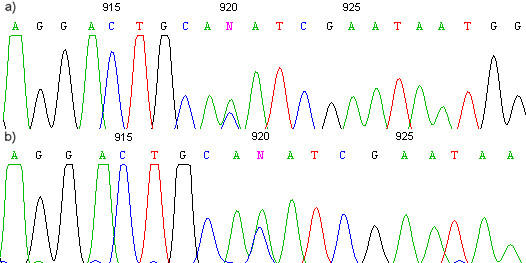
a) Sequence of the index patient with exon 5 c.920A→C heterozygous missense mutation. b) The same mutation sequenced with a reverse primer.